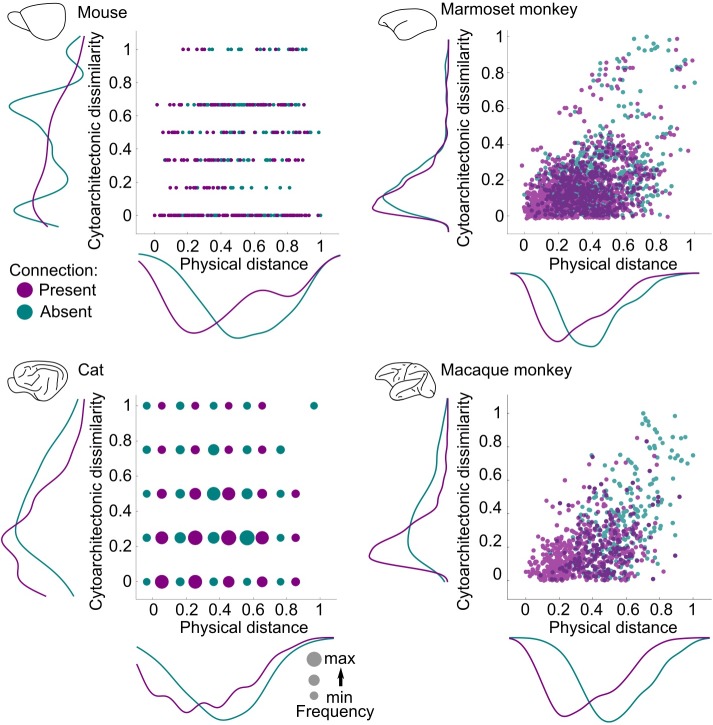
Existence of connections in relation to physical distance and cytoarchitectonic similarity of cortical areas.The existence of connections is reflected in the cytoarchitectonic similarity of cortical areas and the physical distance between them, as is evident in the density plots of each axis. Present connections span short distances and link cytoarchitectonically similar areas, whereas the opposite holds for absent connections. However, for the marmoset monkey, conjoint multivariate examination of cytoarchitectonic similarity and physical distance shows a lack of statistical significance between cytoarchitectonic similarity and existence of connections (S2 Fig), thus pointing out a species-species manifestation of the relation between cytoarchitecture and existence of connections. Depicted cytoarchitectonic similarity and physical distance values are the result of a linear rescaling to the 0–1 interval. Note that for the cat cortex, both physical distance and cytoarchitectonic similarity are ordinal scales, and thus the frequency of presence or absence of connections for each pair of the ordinal values is depicted. Note as well that for the cat cortex, data points correspond only to connections with known status (present or absent) [30]; hence, no data points for certain physical distance and cytoarchitectonic similarity combinations are depicted. max, maximum; min, minimum.